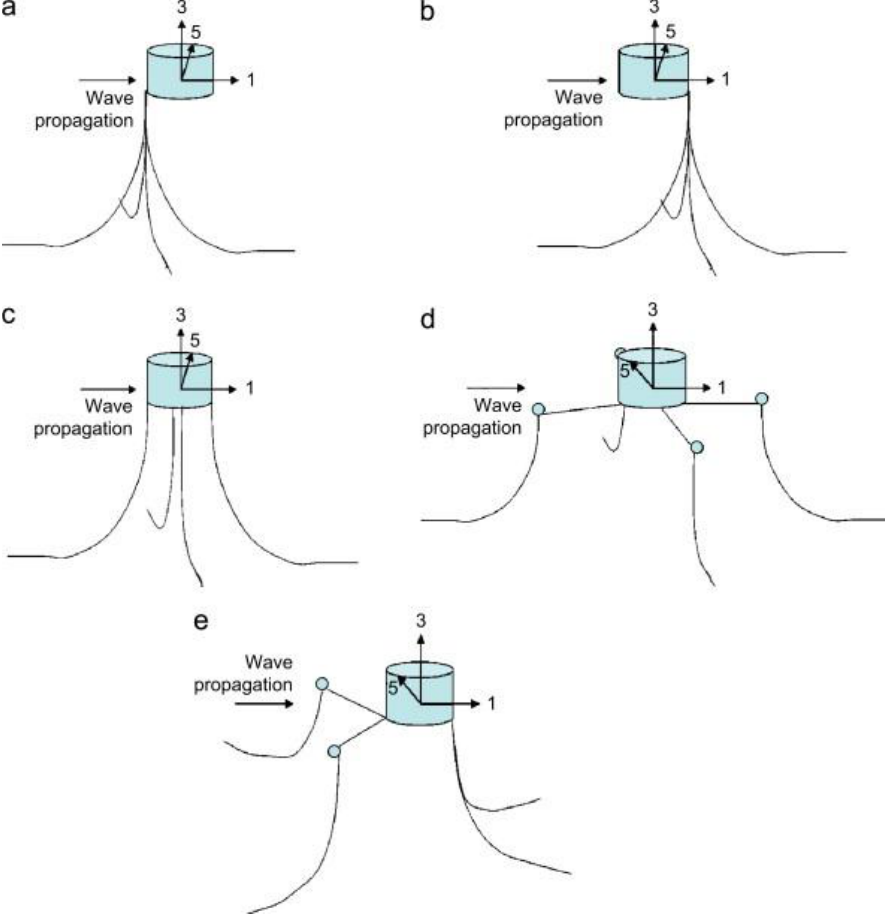
Figure 22. Mooring configurations studied by [112], configuration d was proved to have the best performance in